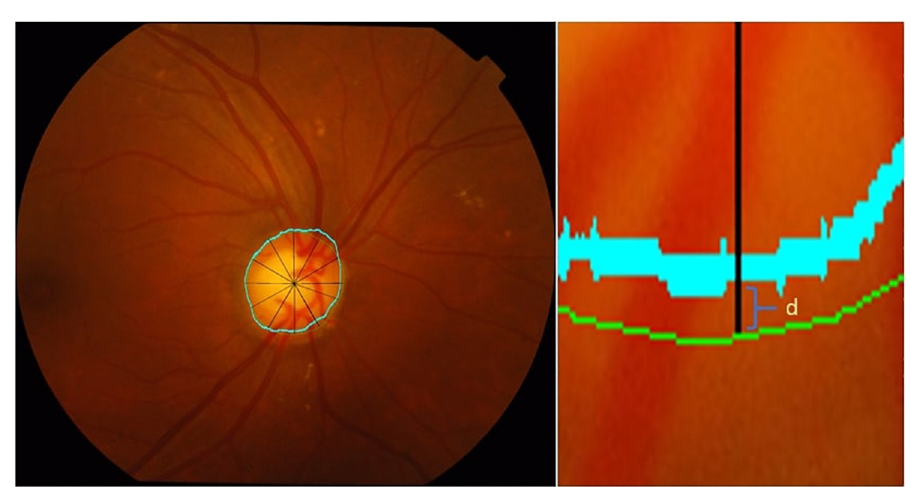
Fig 3. Retinal images showing lines draw from the centroid to expert (green) and optometrist (blue) traced boundary in different directions.